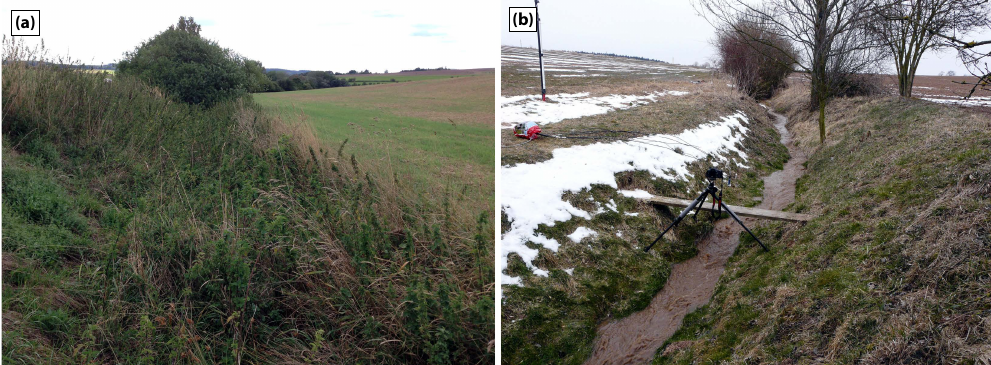
Figure 3. Stream vegetation conditions during the two experiments. Dense instream vegetation in September 2012 (a) and no erect vegetation in March 2013 (b)